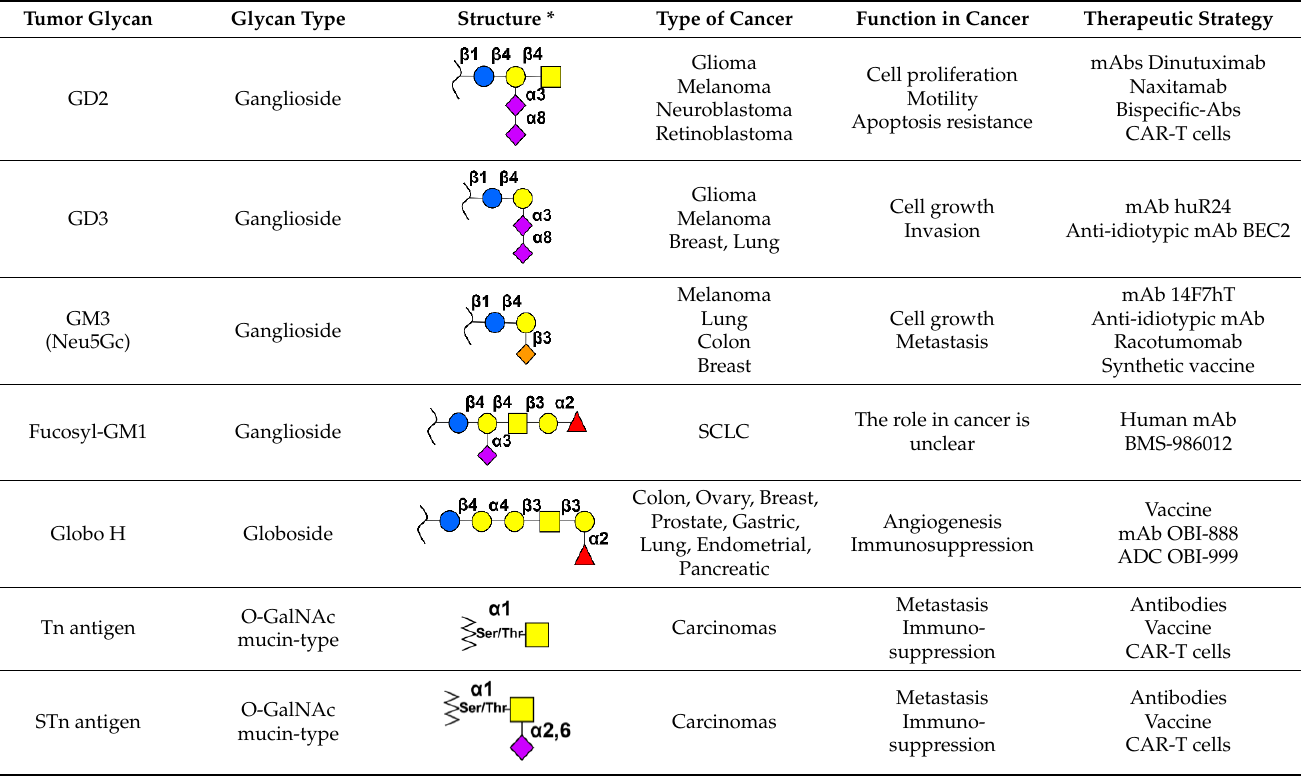
Table 1. Main tumor glycans targeted for cancer therapy.